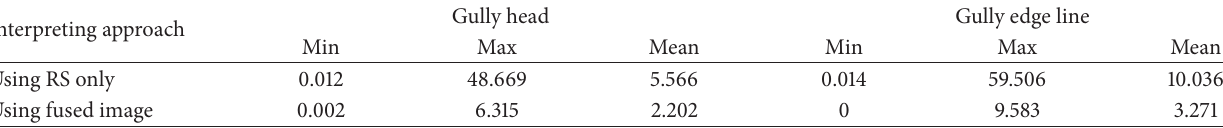
Table 2: The positional errors of gully for the two approaches (unit: